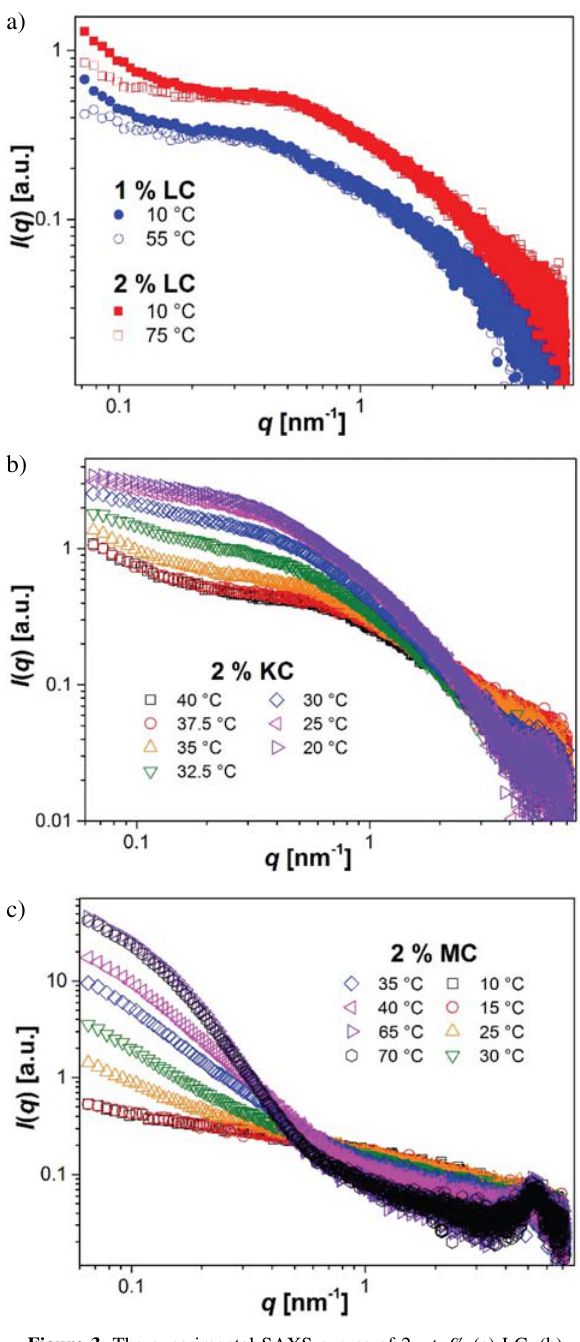
Figure 3 : The experimental SAXS curves of 2 wt. % (a) LC, (b) KC, and (c) MC at different temperatures on a log-log